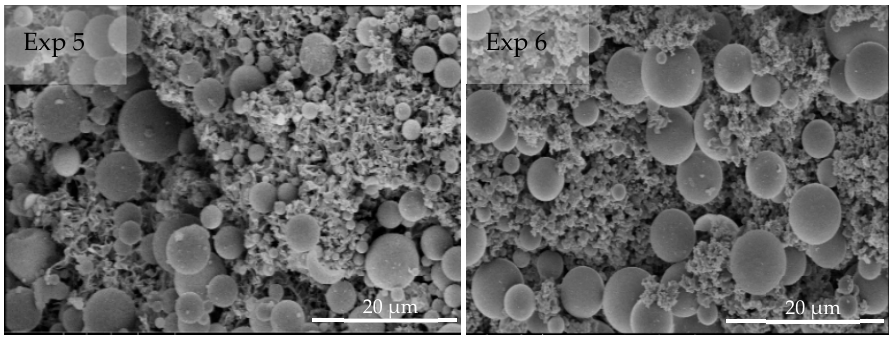
Figure 5. SEM images for deposition experiments 5 and 6.